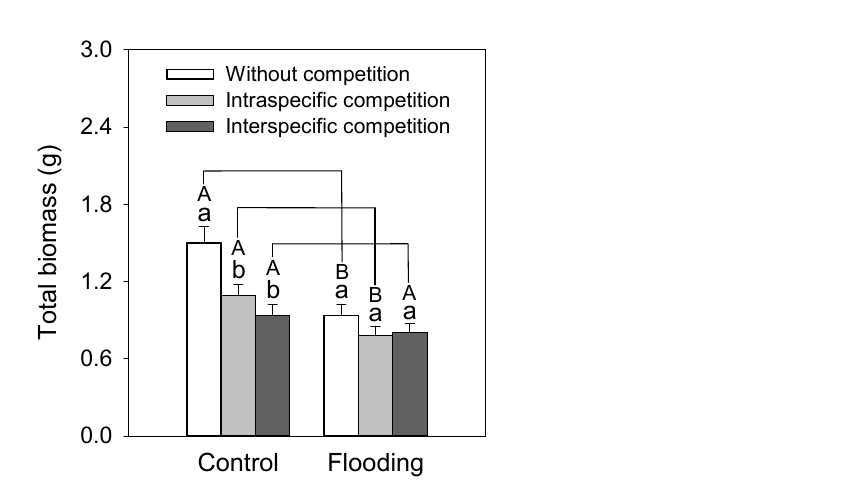
Figure 3. Leaf biomass ( A ), stem biomass ( B ), root biomass ( C ), total biomass ( D ), total leaf area ( E ), plant height ( F ), total chlorophyll content ( G ), Δ F/Fm’ ( H ), and NPQ ( I ) of P. hydropiper under treat- ments with intraspecific competition (i.e., Intra), with interspecific competition (i.e., Inter), or with- out competition (i.e., Without). Data are mean values (+s.e., n = 6). Different letters indicate signifi- cant differences ( p < 0.05).